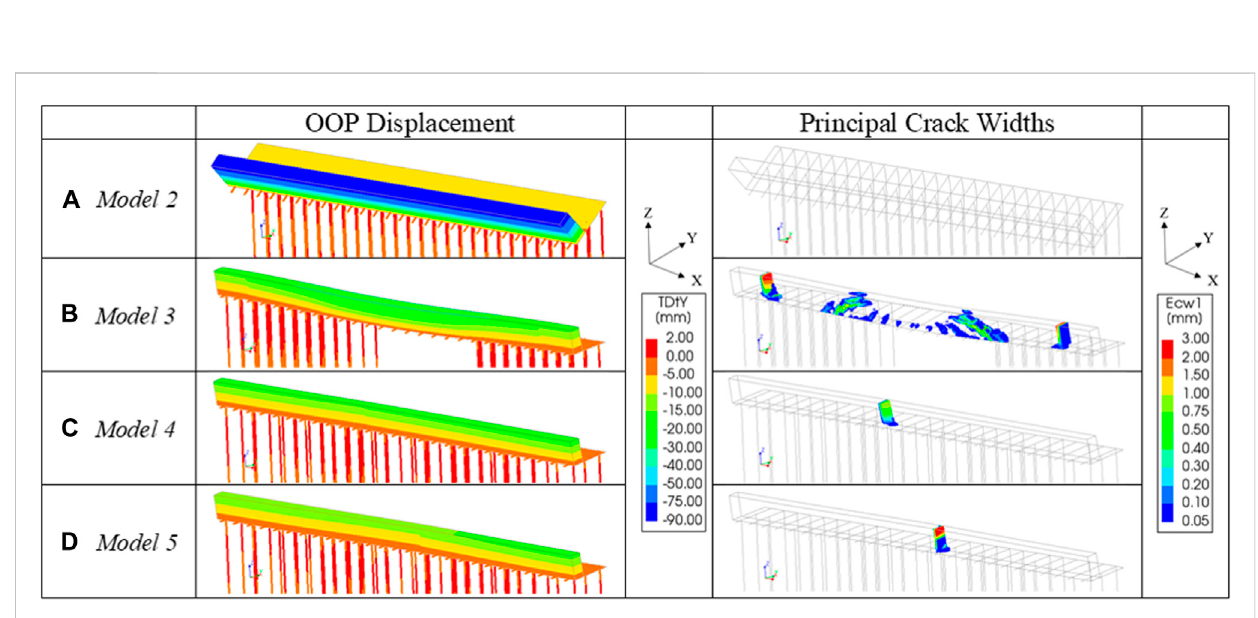
FIGURE 12 Out-of-plane displacements and principal crack widths of the quay wall before application of traf fi c load: (A) Model 2 ; (B) Model 3 ; (C) Model 4 and (D) Model 5 . (Deformation scale factor = 10).